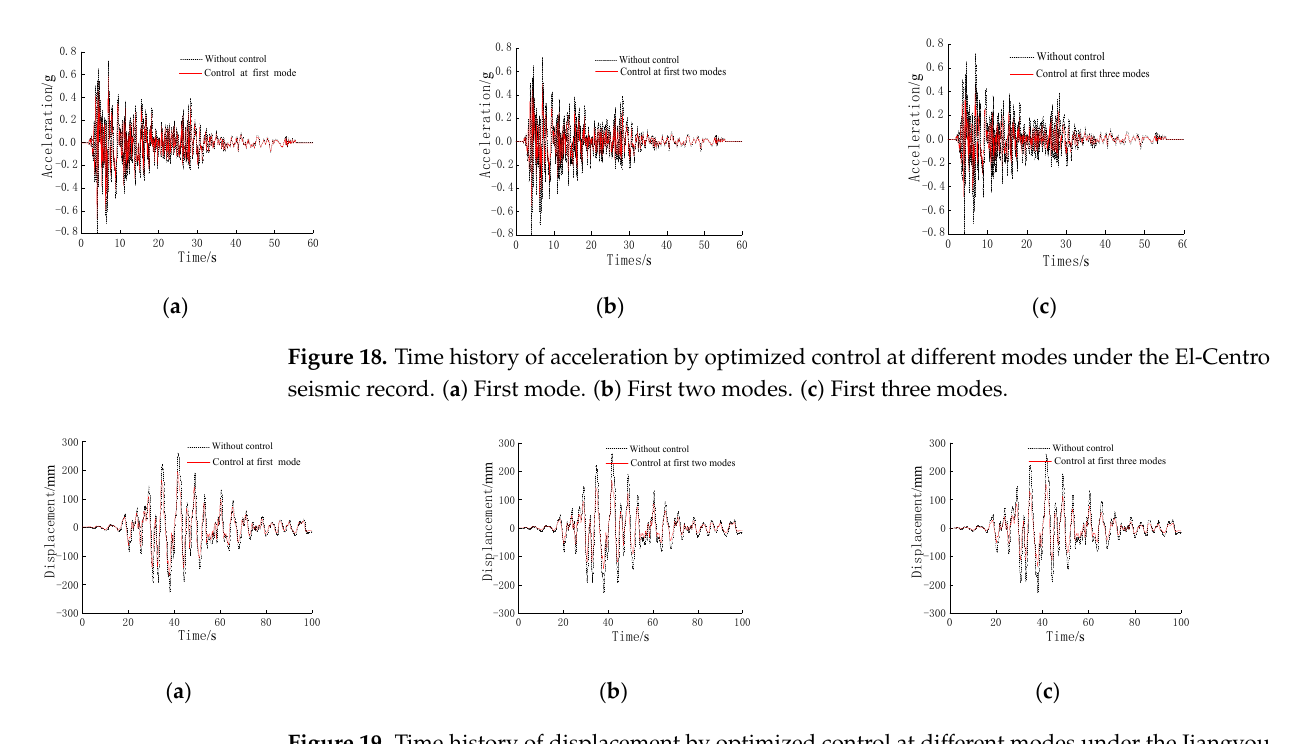
Figure 17. Time history of displacement by optimized control at different modes under the El-Cen- tro seismic record. ( a ) First mode. ( b ) First two modes. ( c ) First three modes.